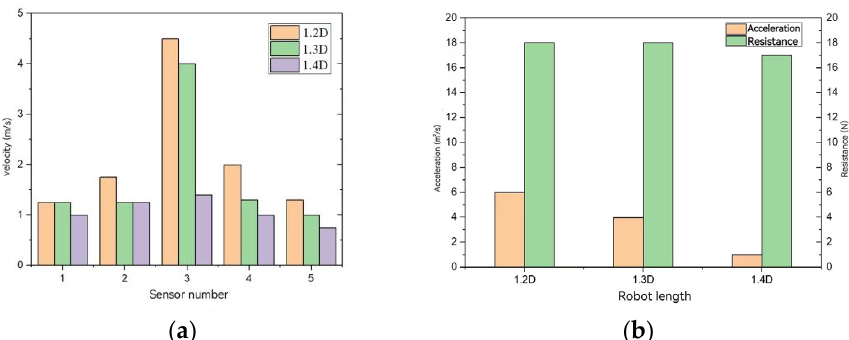
Figure 26. Variations in the velocity of the different robot lengths at the A, B, C and D observation points: ( a ) Different types of robots vary in speed at different positions; ( b ) Acceleration and resistance for different types of robots.